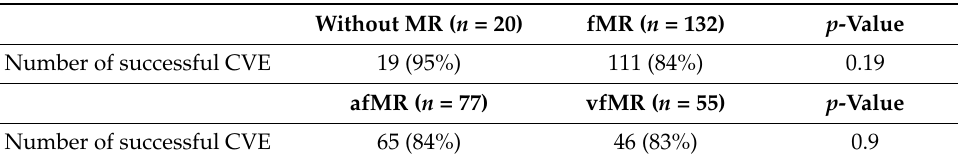
Table 5. Comparison of CVE results between groups of patients without MR and with fMR as well as between patients with afMR and vfMR.